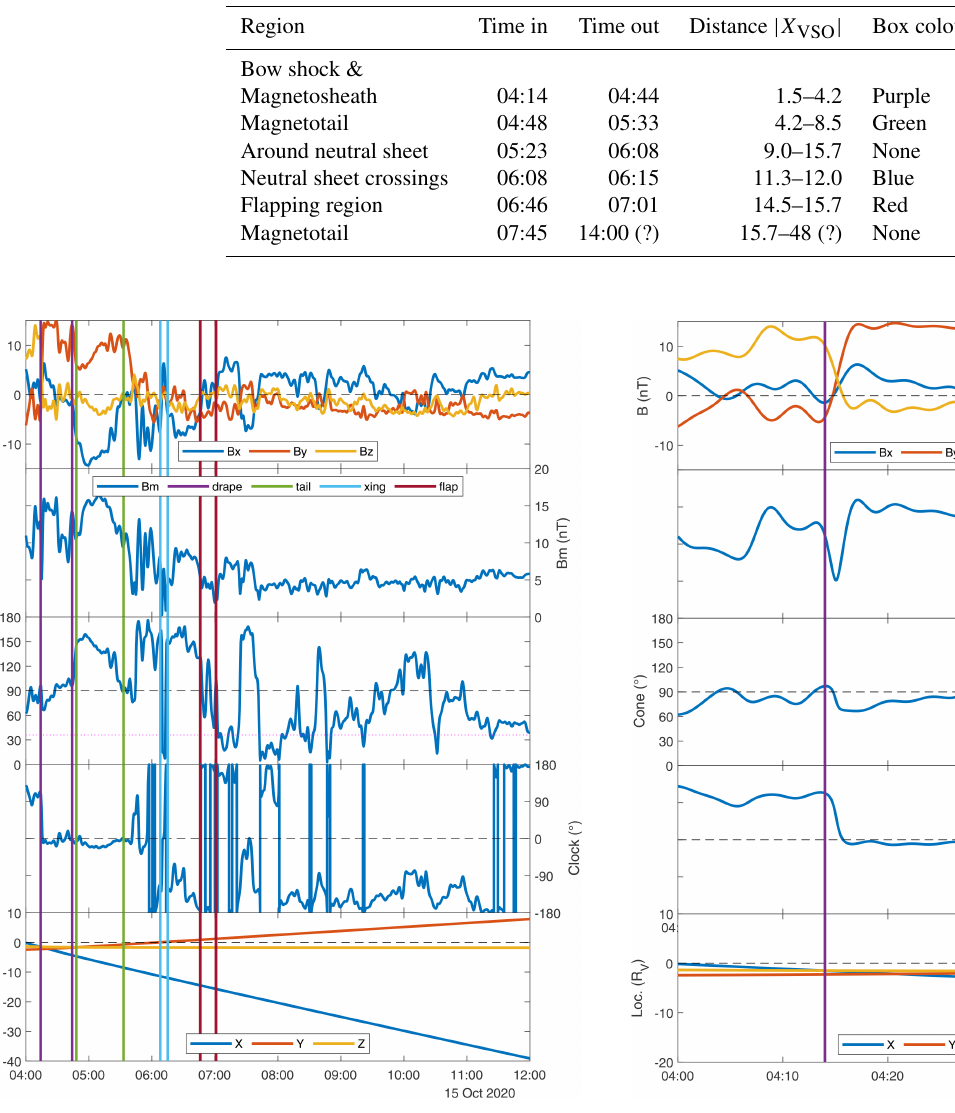
Figure 3. Magnetometer data in the magnetosheath and tail. From top to bottom: the three components of the magnetic field in VSO coordinates; the magnitude of the magnetic field; the cone angle; the clock angle; and the location of the spacecraft in VSO coordi- nates. The purple, green, blue, and red dotted vertical lines show the intervals of interest.